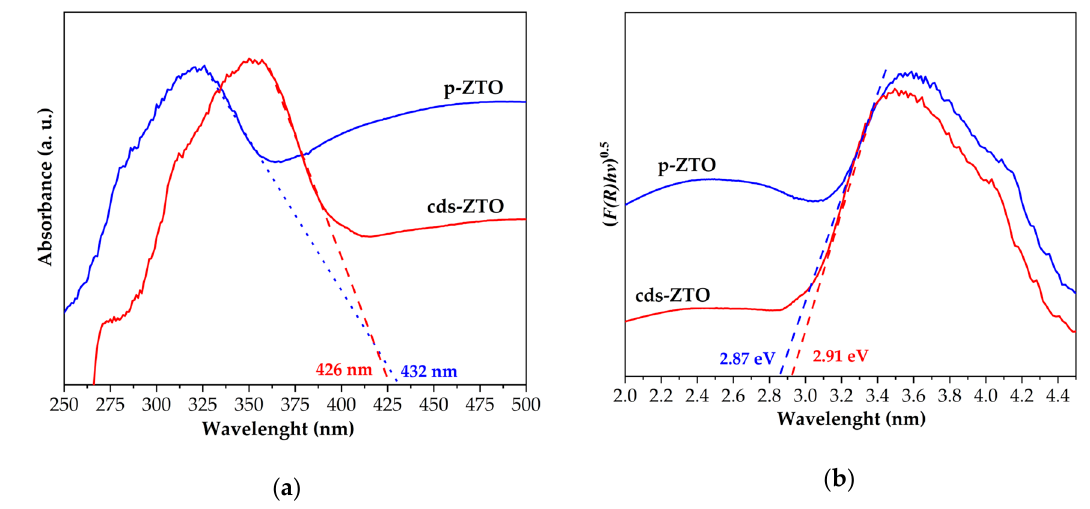
Figure 8. ( a ) Absorption spectrum of cds-ZTO and p-ZTO and ( b ) Tauc plots for the estimation of the indirect bandgap for cds-ZTO and p-ZTO.